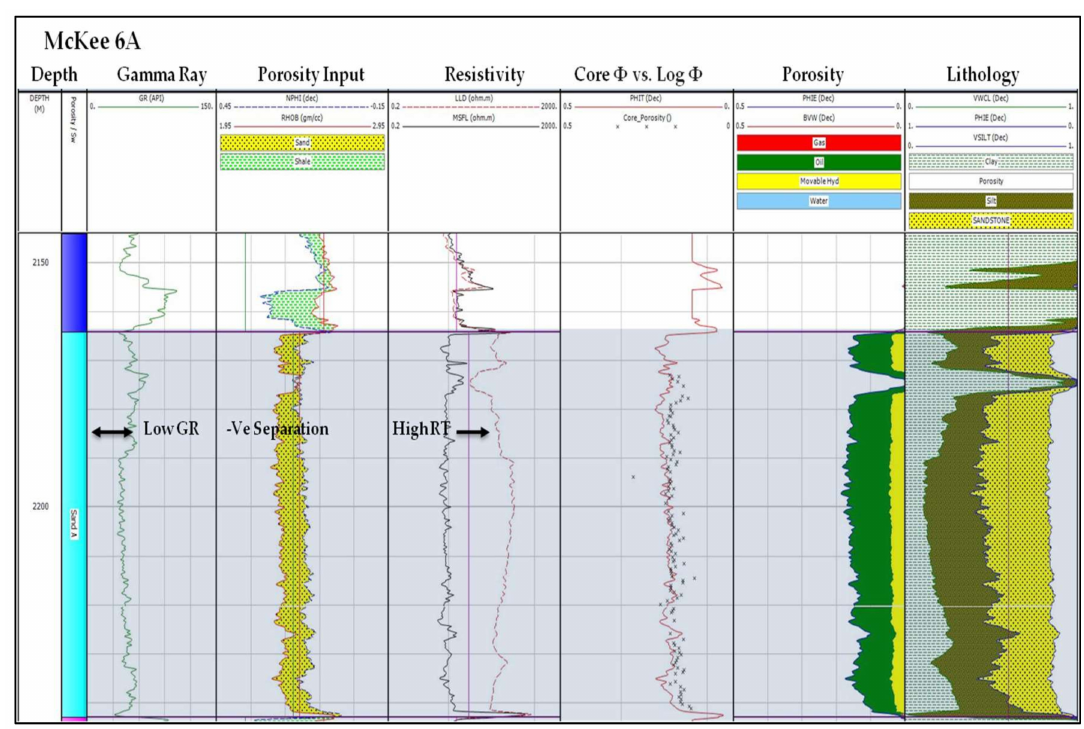
Figure 10. Litho-saturation plot of McKee 6A. GR: Gamma Ray; -Ve Separation: Negative Separation; RT: High Resistivity.